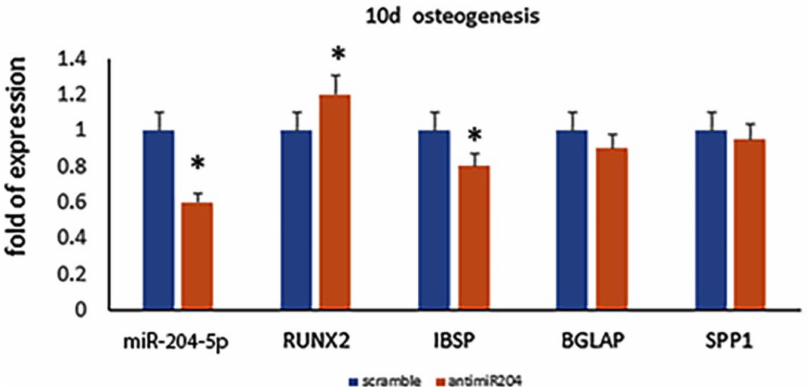
Figure 5. miR-204-5p and osteogenic (RUNX2, COL1A1, IBSP, BGLAP, SPP1) mRNA expression levels quantified by RT-PCR at a late (10 days) differentiation phase in miR-204-5p-silenced MSCs. (* p < 0.05 vs.